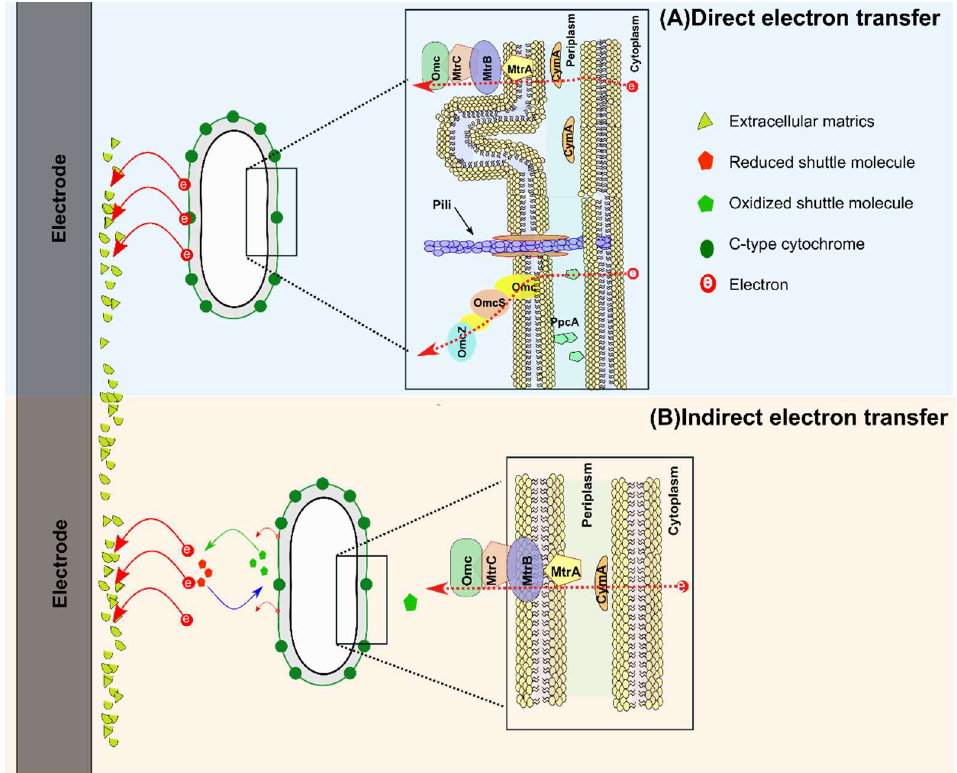
Figure 1. Schematic illustration of extracellular electron transfer mechanisms at microbe-electrode interface in bioelectrochemical systems, ( A ) Direct electron transfer; ( B ) Indirect electron transfer, adapted and modified from [16] with the permission from nature publishing group.